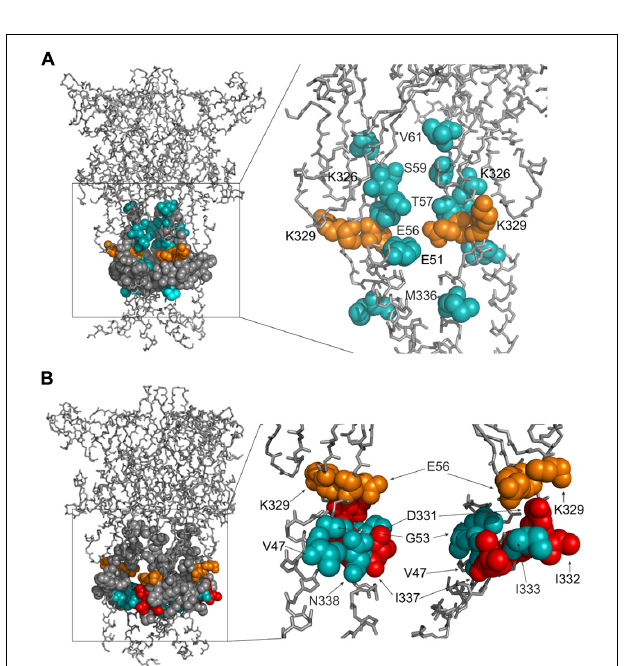
FIGURE 4 | Protocol 2: the effect of cadmium on sustained current response by mutant rP2X4Rs. The whole-cell current recordings from − 60 mV represent the effects of 20 μ M cadmium transiently co-applied (gray field) with 100 μ M ATP. Cadmium application was initiated at 50 ± 10% of current desensitization decay. (A) Enhancement of cadmium effects in cysteine mutants (red traces) and